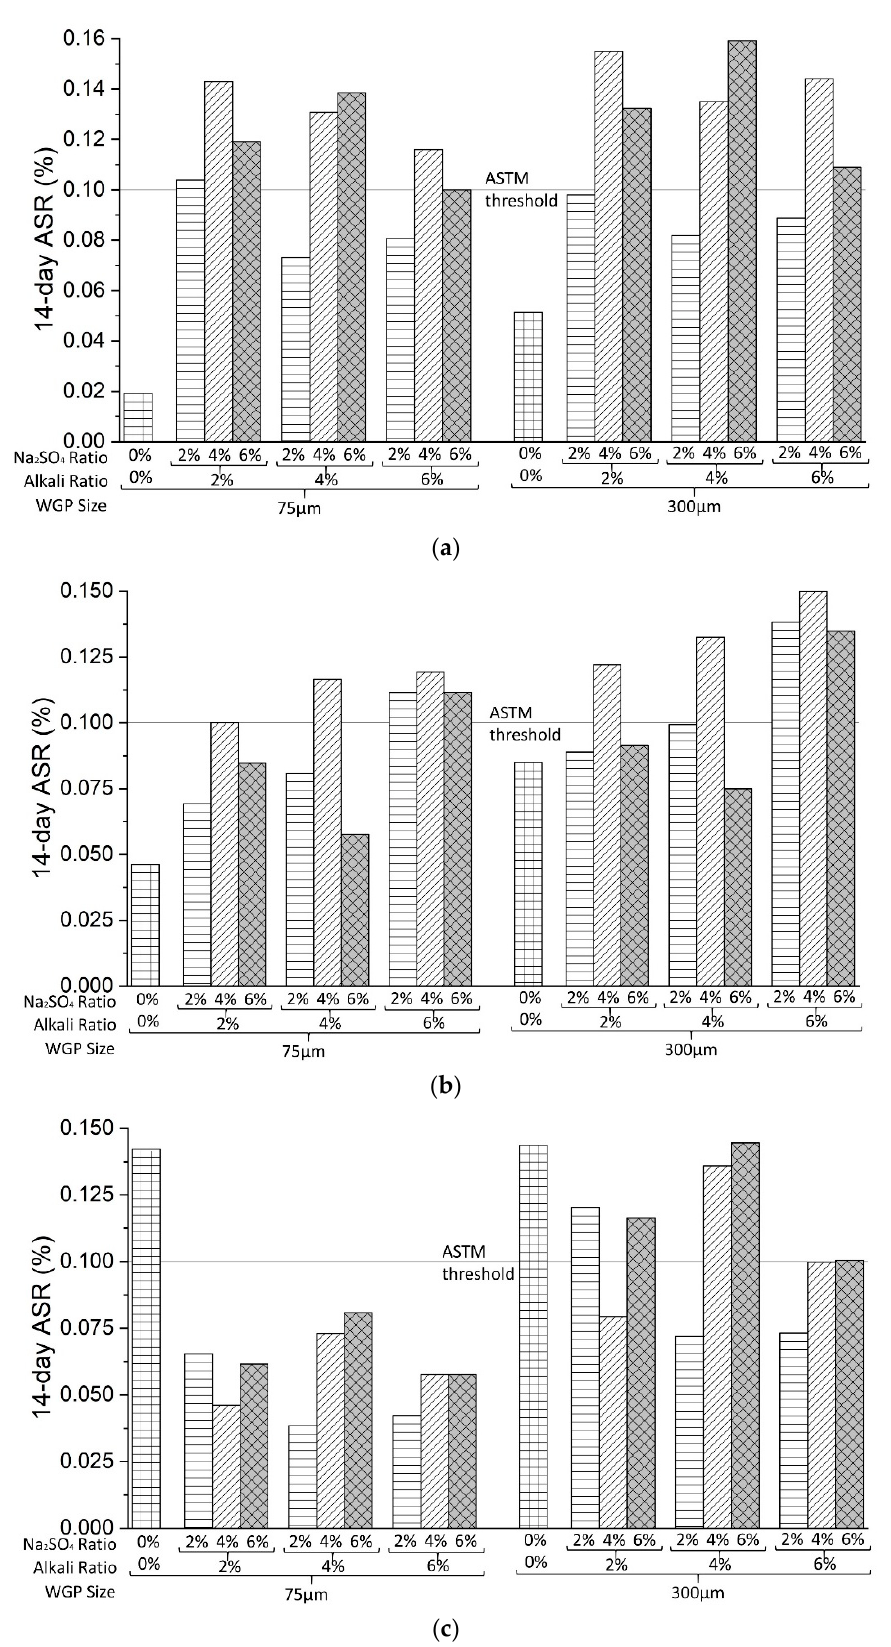
Figure 9. The 14-day ASR values of bar samples containing ( a ) 10%, ( b ) 20%, and ( c ) 30% chemically activated WGP.